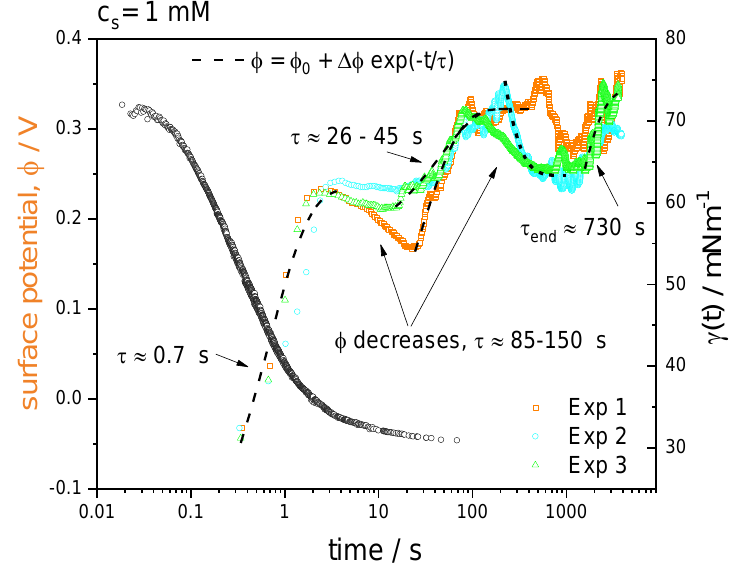
Figure 6. Surface potential curves (symbols in color, left axis) superimposed to the dynamic surface tension, γ ( t ) (circles, black, right axis) for a solution at a surfactant concentration of 1 mM. We show three independent surface potential experiments (Exp 1, 2 and 3) to illustrate the “reproducibility” of such measurements.